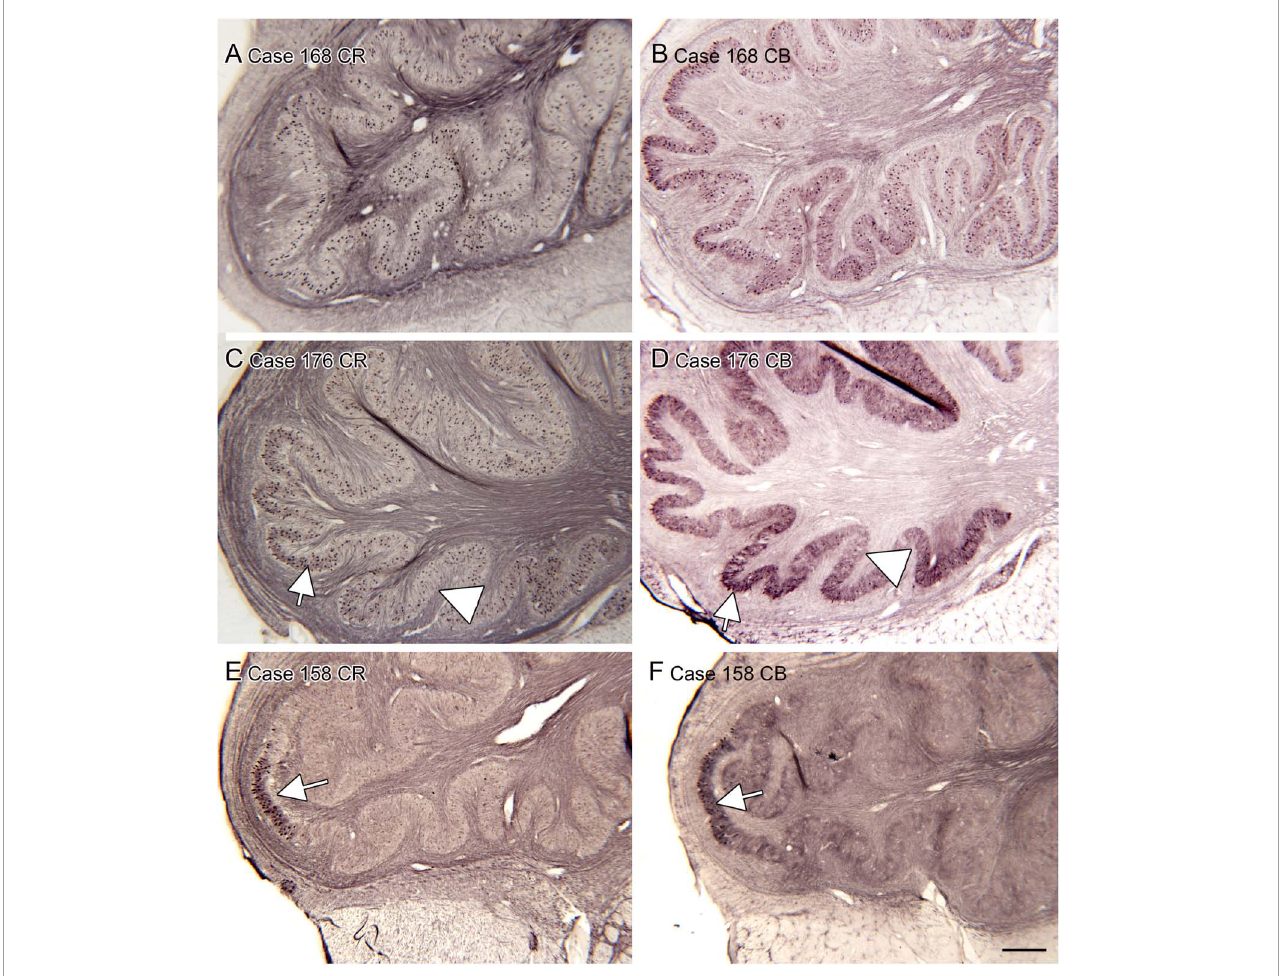
FIGURE6 Variability in the expression of calcium-binding proteins calretinin (CR) and calbindin (CB) in the IOpr of humans. We show pairs of sections from three different cases showing CR-ir and CB-ir neurons. (A,B) Case 168; there are many immunolabeled neurons over the IO ribbon with some local differences in density. (C,D) Case 176. (E,F) Case 158. Note the (arrows) small patches of densely immunoreactive cells. Scale bar in panel (F) = 500 µ m (applies to all